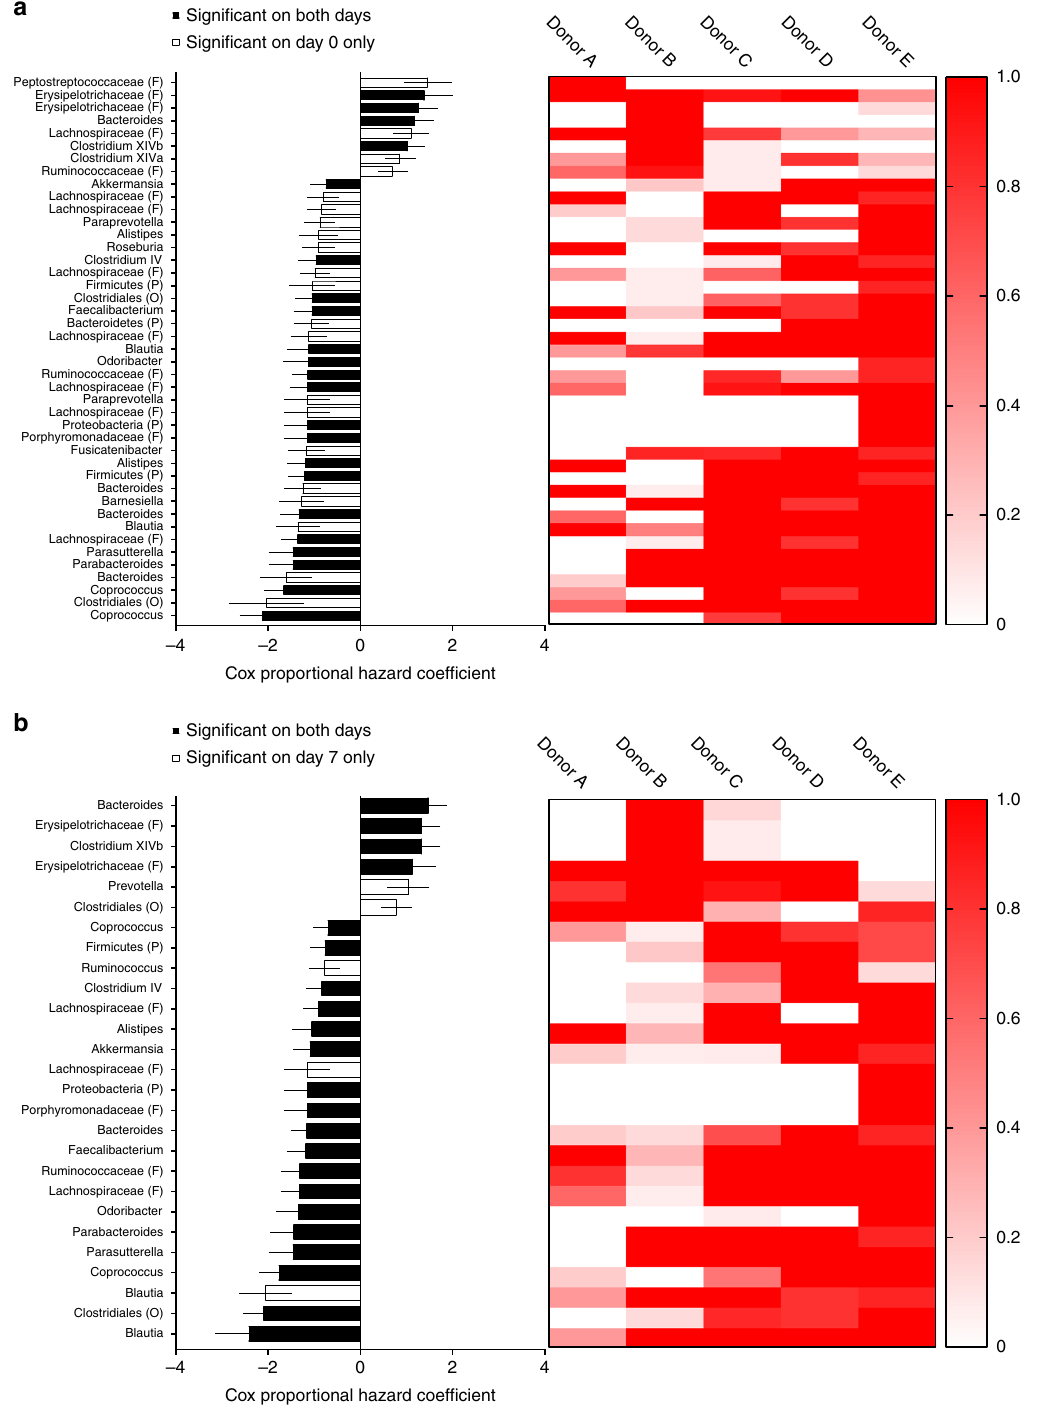
Fig. 5 Speci fi c microbiome OTUs are risk factors for survival. The presence/absence of the 100 most abundant OTUs in the dataset were fi t to univariate Cox proportional hazards (CPH) models. a , b Controlling for false discovery rate (<0.1), signi fi cant beta coef fi cients (with standard error) for microbiome members at day 0 ( a , left panel) and day 7 ( b , left panel) are shown along with the group-wise prevalence of each OTU displayed as heat maps ( a , b , right panels). Donor groups in heat maps (A – E) are ordered by median survival during arsenic exposure (shortest survival on left, longest survival on right). Signi fi cant OTUs found on both sampling days (0 and 7) are shown with black bars and signi fi cant OTUs found to be unique on one day or the other are shown in open bars. CPH models correlate explanatory variables with a relative hazard function, therefore, a negative beta coef fi cient indicates a protective association, while positive coef fi cients are associated with increased hazard. OTUs were classi fi ed to the lowest taxonomic level at a 95% con fi dence. Taxonomic levels above genera are indicated in parentheses (F family, O order, P